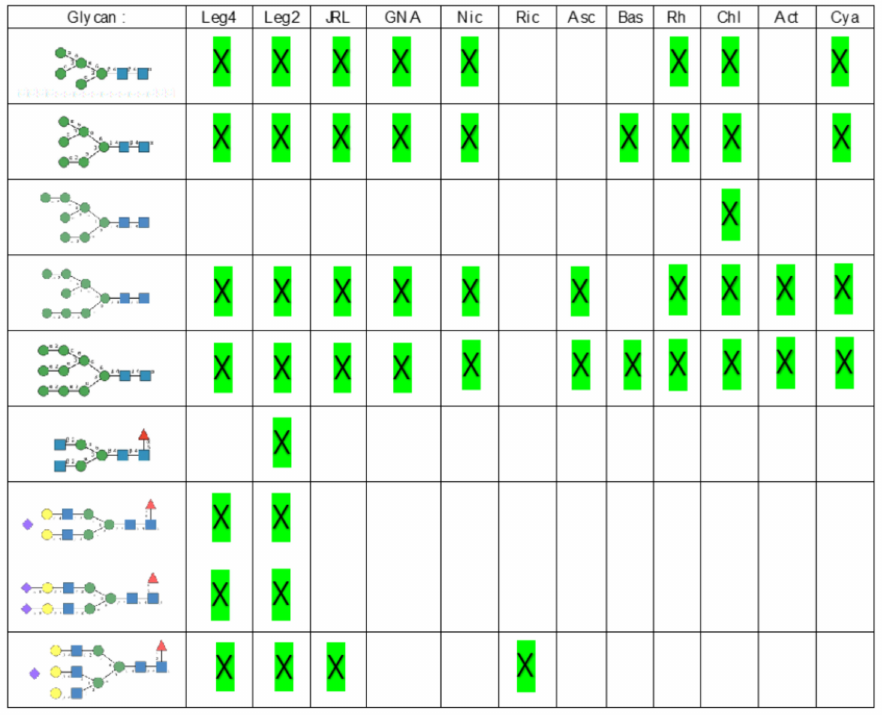
Figure 32. MERS-CoV glycans that can be recognized (X) by Man-specific lectins from plants, mushrooms, algae, and cyanobacteria, as predicted from the results of glycan arrays performed with purified lectins: Leg4 (Con A): single-chain legume lectins; Leg2 (PsA, LcA): two-chain legume lectins; JRL (Morniga-M): jacalin-related lectins; GNA (GNA, ASA): GNA-like lectins; Nic: Nictaba from Nicotiana tabacum ; Ric: ricin-B from Ricinus communis ; Asc (NcCVN): lectins from Ascomycota; Bas (ABA): lectins from Basidiomycota; Rh (griffithsin, KAA-2): lectins from Rhodophyta; Chl (BCA): lectins from Chlorophyta; Act (actinohivin): lectins from actinomycetes; Cya (cyanovirin): lectins from